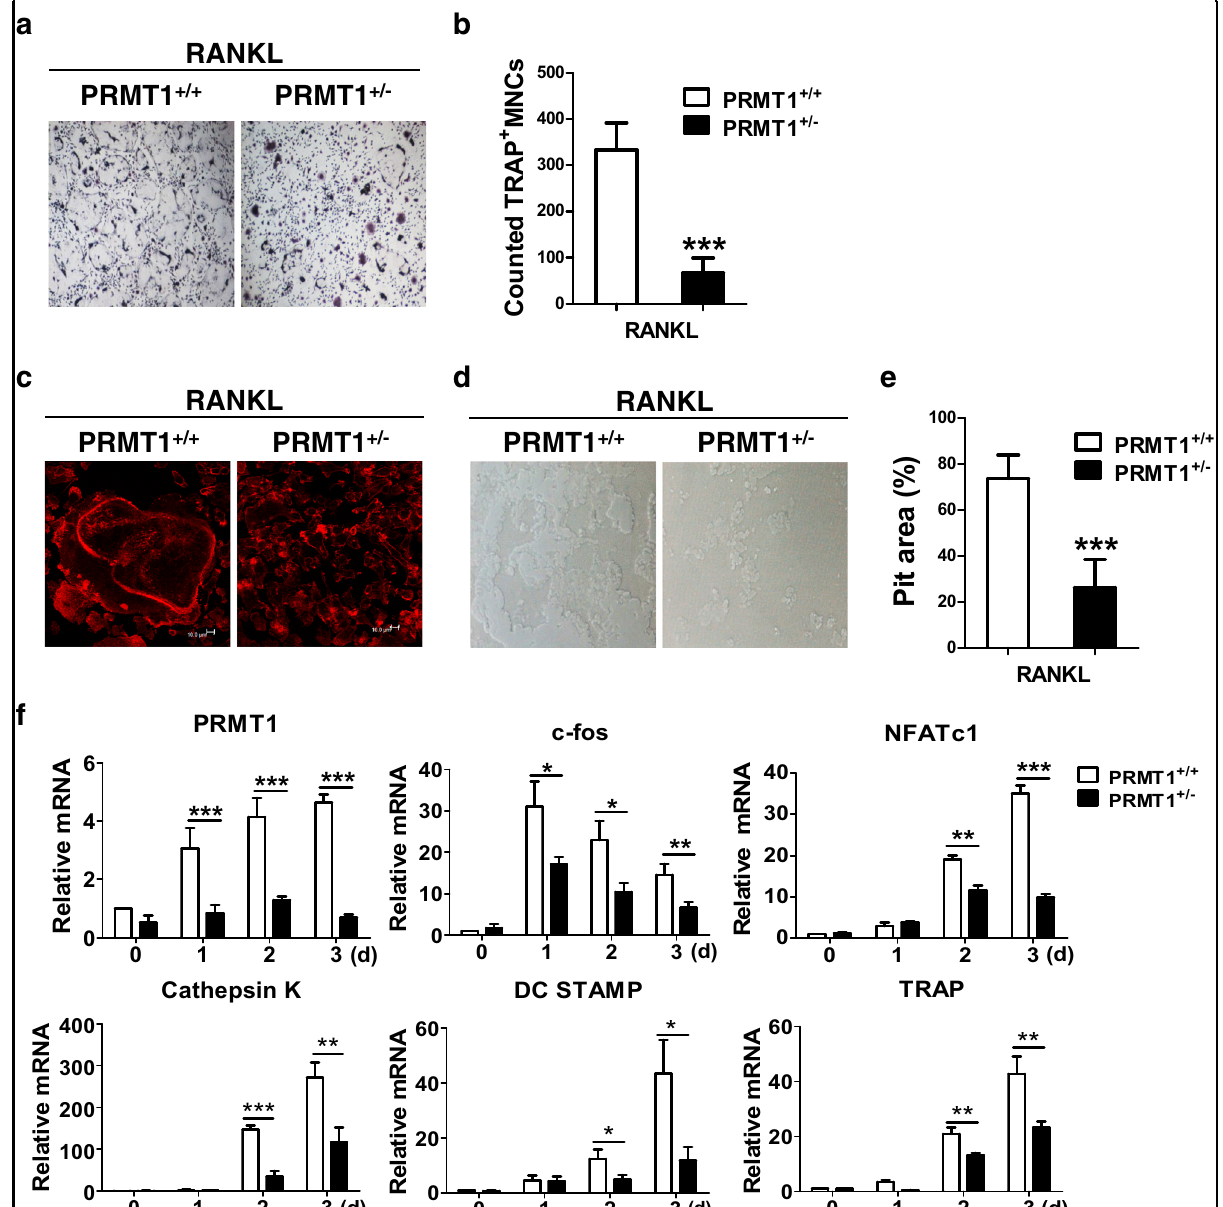
Fig. 3 RANKL-induced osteoclastic differentiation and bone resorption alleviated in BMDMs from PRMT1 - haploinsuf fi cient mice. a-f BMDMs from PRMT1 + / + and PRMT1 + /- mice were incubated with M-CSF (30 ng/ml) and RANKL (100 ng/ml). a , b The cells were stained for TRAP activity, and the number of osteoclasts was counted after staining for TRAP activity. c The cells were fi xed and stained with Alexa Fluor 594-phalloidin for F-actin. d , e BMDMs from PRMT1 + / + and PRMT1 + /- mice were cultured on an Osteo Assay Surface Plate for 3 days and then removed. Resorption pits were visualized with light microscopy, and the percentage was obtained using the image J program. The representative images are from at least three independent experiments. f The levels of the indicated mRNAs were measured using real-time PCR analysis and were then normalized to the β - actin level. The results are expressed as the mean ± SD. * p < 0.05, ** p < 0.01, *** p <